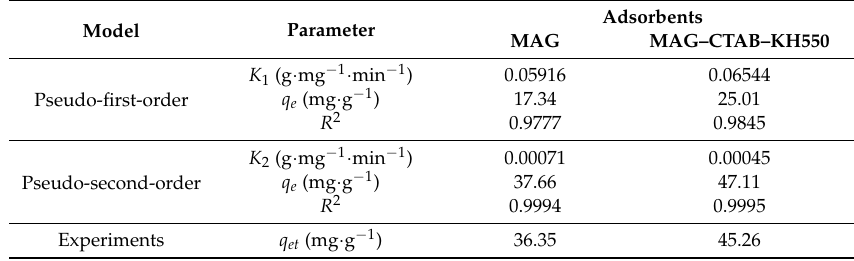
Table 3. Adsorption kinetic constants of phenol for MAG and MAG–CTAB–KH550 (pH = 10, 1 g/L of sorbents dosage).